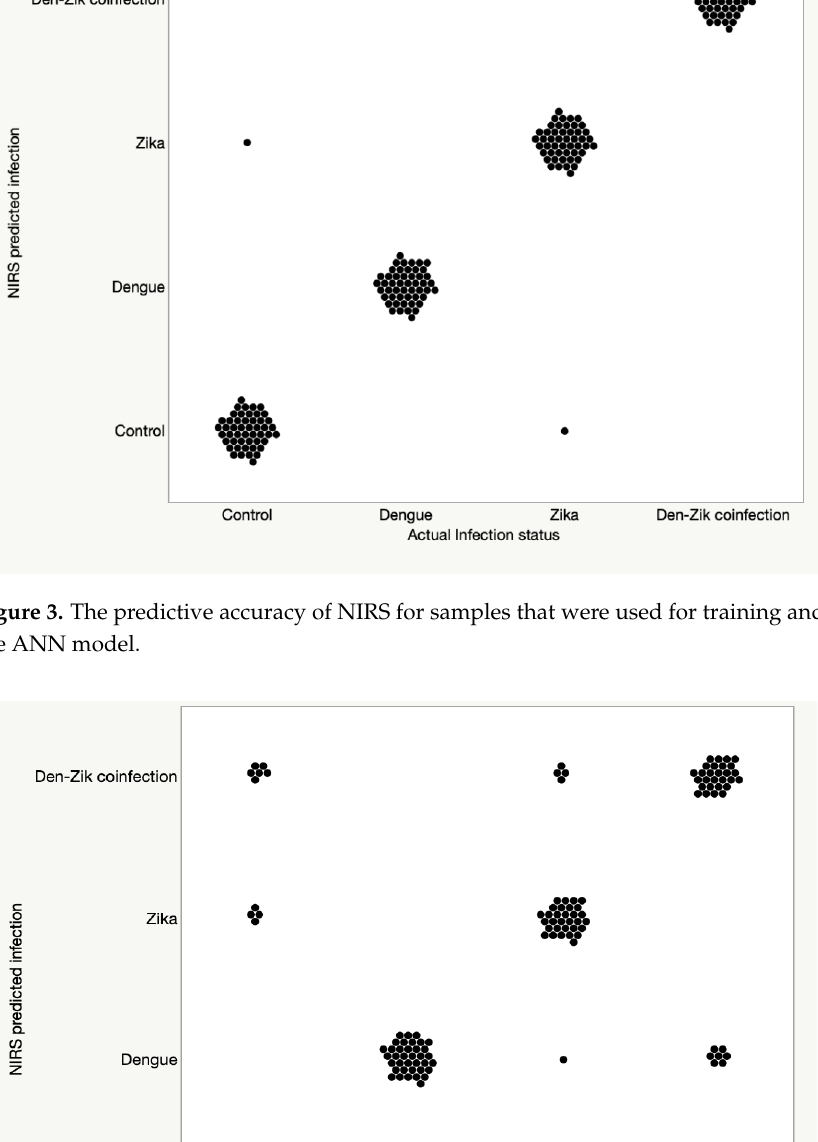
6 of 13 Table 2. Prediction accuracy for Ae. aegypti infection status in training/validation set and test set. Mosquitoes could be infected with either DENV or ZIKV single infection, coinfected with DENV and ZIKV or uninfected (control). Training and Validation Set